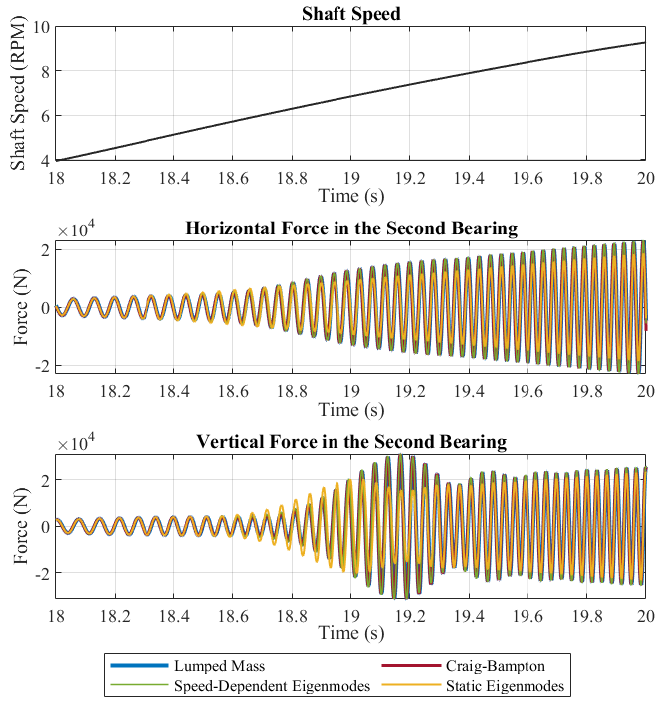
Figure 9. Time series snapshot of the simulated shaft speed and bearing forces for all four models.